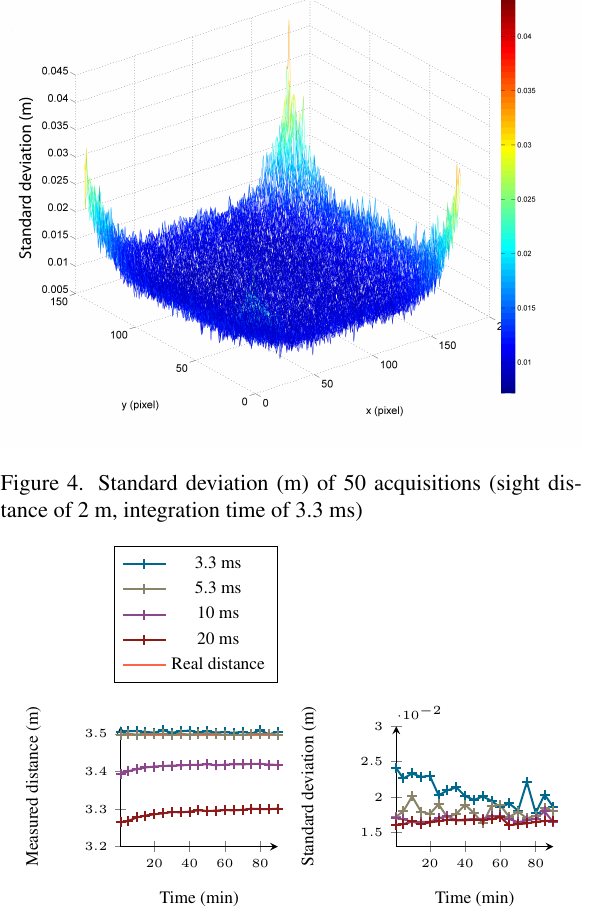
Figure 5. Evolution of the measured distance (left) and standard deviation (right) with time for different acquisition times a sight distance of 3.5 m for 4 different integration time: 3.3, 5.3,